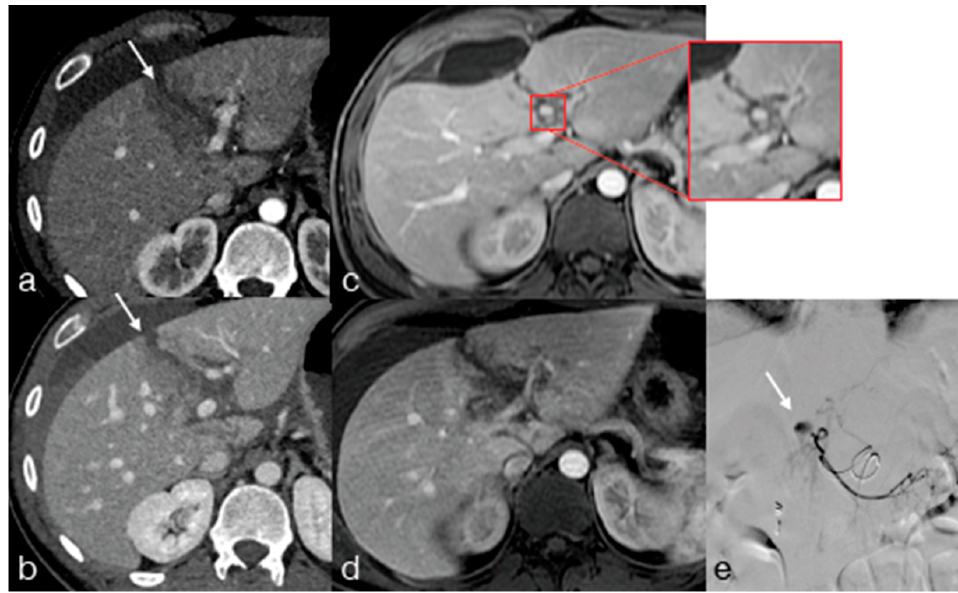
Figure 11. Thirty-four-year-old male underwent high-energy trauma with high-grade liver laceration. Enhanced CT upon admission for arterial ( a ) and portal ( b ) phase showing the liver injury ( a , b ) arrow), and at the MR follow-up performed 14 days later, the patient developed an arterial pseudoaneurysm (( c ), T1W Fat Sat, arterial phase, red box) seen only in the arterial phase (( c ) red box and ( d ) portal phase), which was confirmed and embolized at the following angiography (( e ),